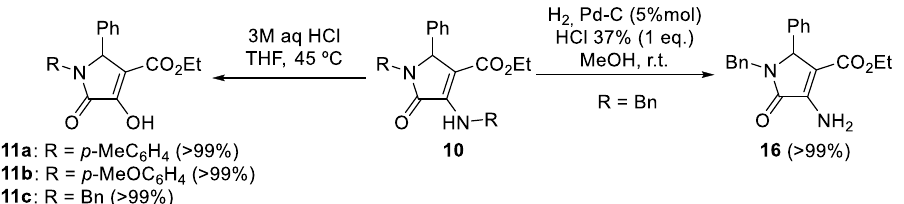
Scheme 4. Preparation of enol derivatives 11 and deprotection of benzylamine derivative 10 .